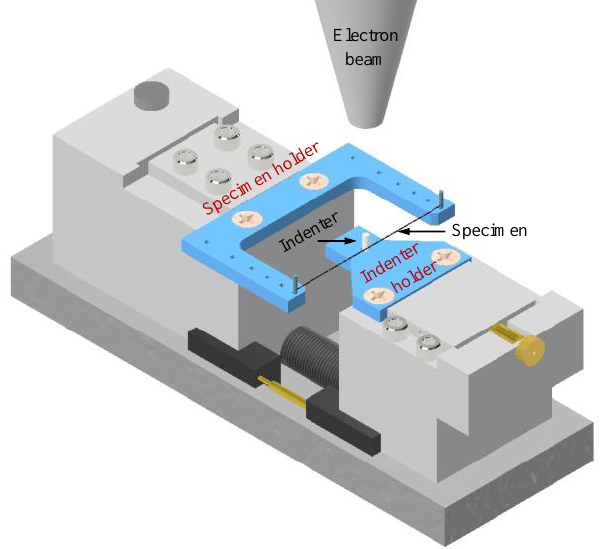
Figure 3. Single-fiber transverse loading experimental setup.